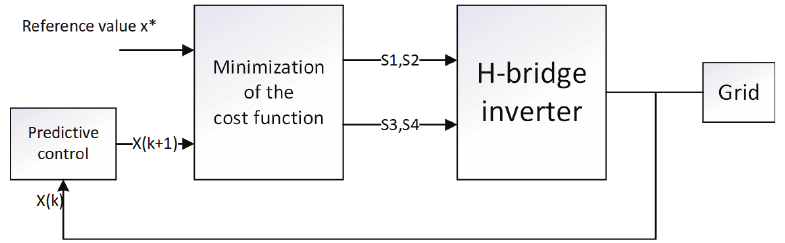
Figure 3. General scheme for proposed